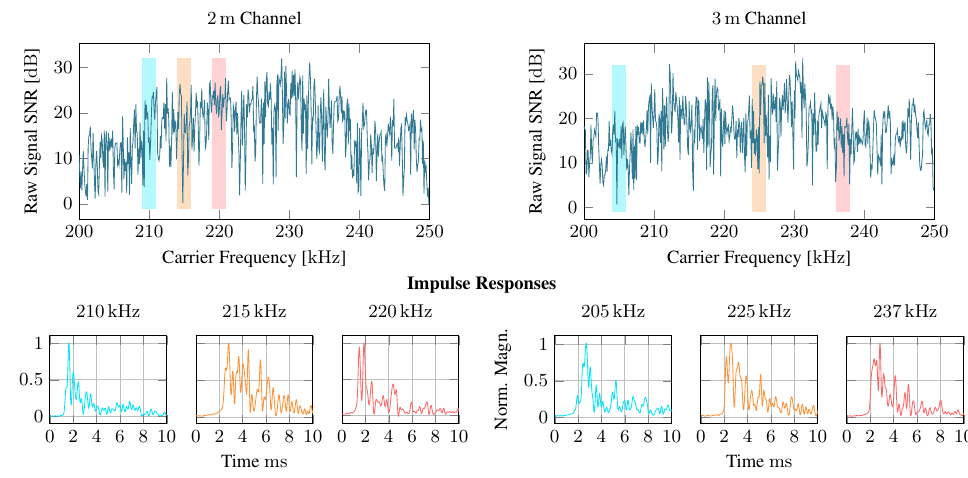
Figure 14. SNR over the raw signal and after equalizing the received messages in 2 and 3 m channels. Next, we transmitted 250 messages through each channel for each selected frequency and decoded them using our SDR pipeline, as described in Section 3.4, using the internal oscillator at the tag once and the more stable external oscillator once. The modulation scheme was 4-PSK at a symbol rate of 1000 symbols per second, yielding a total data rate of 2 kbit s − 1 . Each packet contained 200 payload bits.